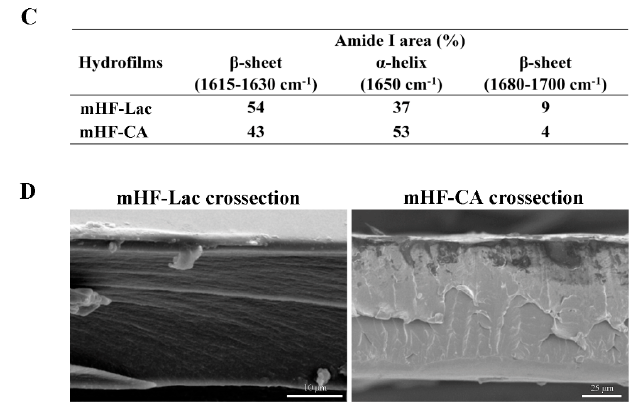
Figure 3. Gelatin crosslinking. ( A ) Representation of the early stage of Maillard reaction between gelatin and lactose (gal = galactose) and the chemical reaction between gelatin and citric acid. ( B ) Fourier-transform infrared (FTIR) spectra of mHF-Lac and mHF-CA. ( C ) Protein conformation in gelatin films crosslinked with lactose or citric acid. ( D ) Scanning electron microscopy (SEM) analysis of mHF-Lac and mHF-CA cross-section.